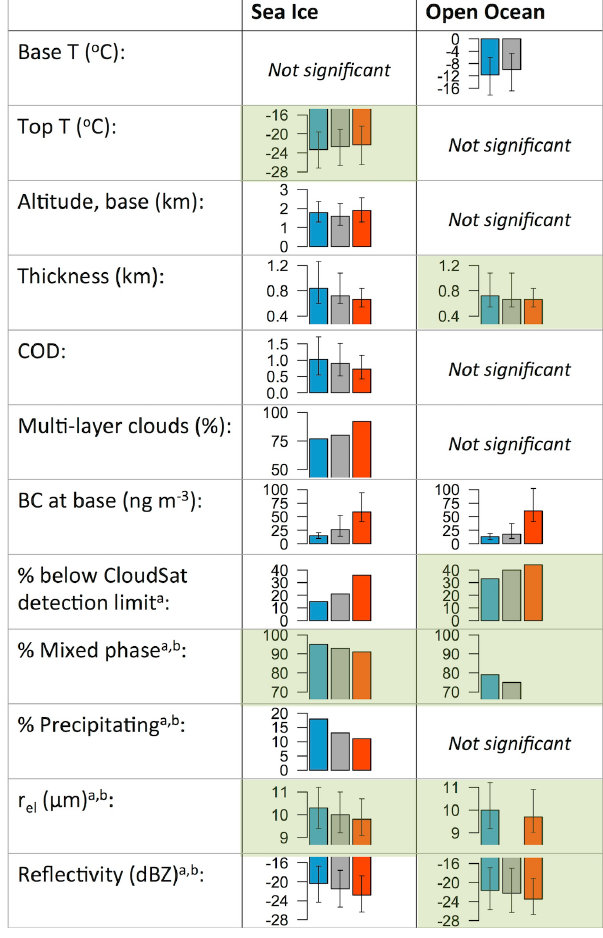
Figure 4. Following Table 2, median characteristics of all (grey) and aerosol-influenced (orange) ONLi clouds over sea ice and open ocean where significant differences from clean conditions (blue) are observed. Data are not shown for cases without significant dif- ferences between clean and non-clean clouds. Bars denote the in- terquartile range of the data. Green shading indicates that signif- icant differences were only observed in non-shallow ( > 1.1km) clouds. Where indicated, data were only available for a clouds with bases > 750ma.s.l., or b for clouds with CloudSat reflectivi- ties > −